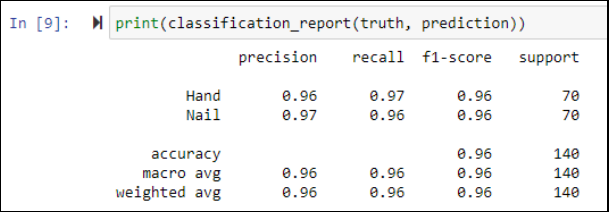
Fig. 15. Classification report